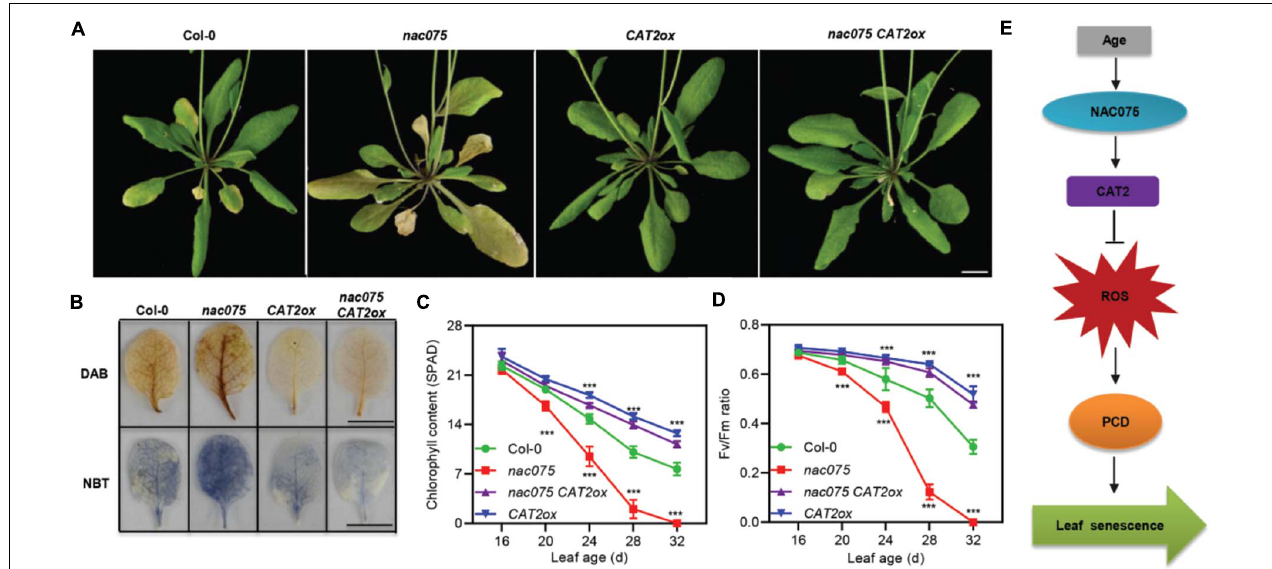
FIGURE 5 | Overexpression of CAT2 suppresses the early senescence phenotype of nac075 mutant plants. (A) Leaf senescence phenotype of 32-day-old Col-0, nac075 , nac075 CAT2ox , and CAT2ox plants. The scale bar represents 1 cm. (B) DAB and NBT staining were used to detect H 2 O 2 and O − 2 accumulation, respectively, in the third or fourth leaves of Col-0, nac075 , nac075 CAT2ox , and CAT2ox plants. The brown and blue color represent H 2 O 2 and O − 2 accumulation, respectively. Scale bar, 1 cm. (C,D) Measurements of chlorophyll contents (C) and photochemical efficiency (Fv/Fm) (D) in Col-0, nac075 , nac075 CAT2ox , and CAT2ox plants as leaves age. Data are represented as means ± SD, n = 3. The experiment was performed three times with similar results. Student’s t- test, *** P < 0.001. (E) A proposed model illustrates the transcription factor NAC075 that delays leaf senescence by deterring reactive oxygen species accumulation in Arabidopsis . NAC075 promotes CAT2 transcription by directly binding to its promoter, which is able to suppress ROS overproduction. Decreased ROS levels are capable of reducing programmed cell death, thereby delaying leaf